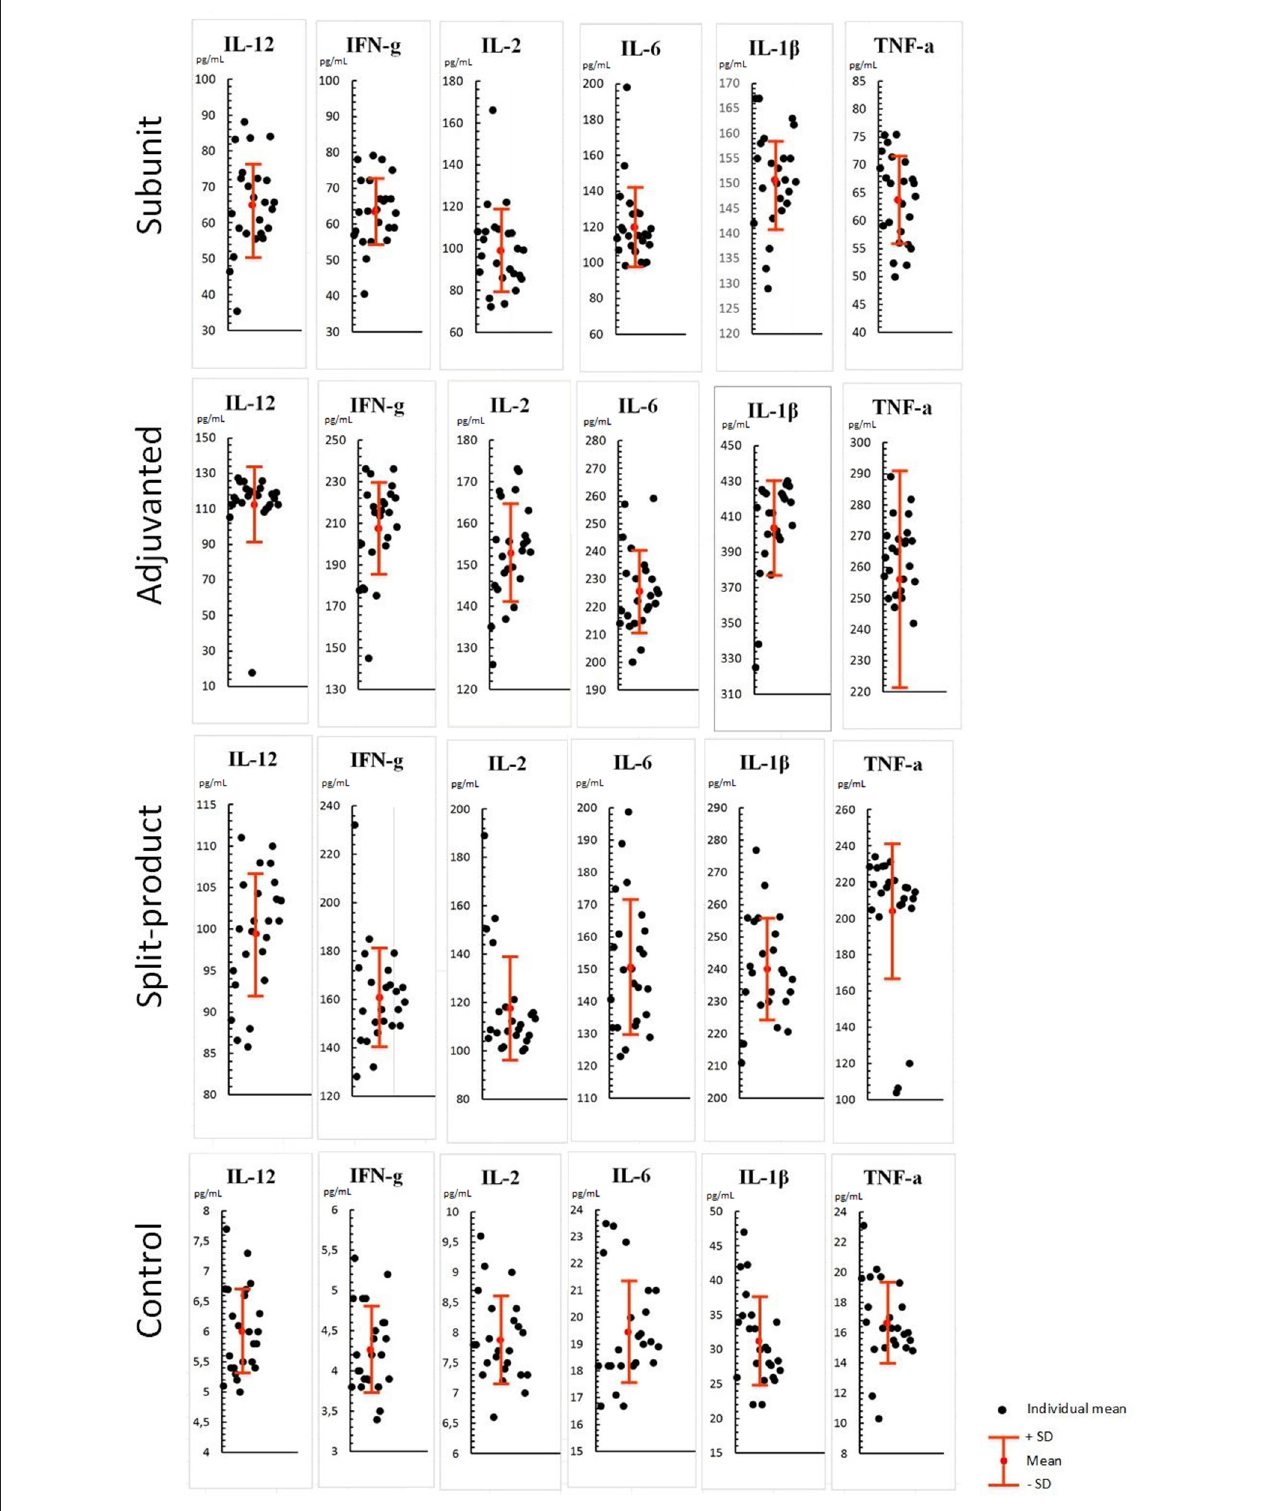
FIGURE 1 | Effect of vaccines against influenza on Th-1 cytokine levels in PBML culture. PBML were isolated from peripheral blood. Cytokine level in PBML supernatants was determined 24h after incubation with vaccines against influenza by flow cytometry. All data are shown as individual means, M (mean values) ± SD (standard deviation). The significance of differences between mean values at each time point was tested by Mann–Whitney rank sum tests for independent samples ( P ≤ 0.05).